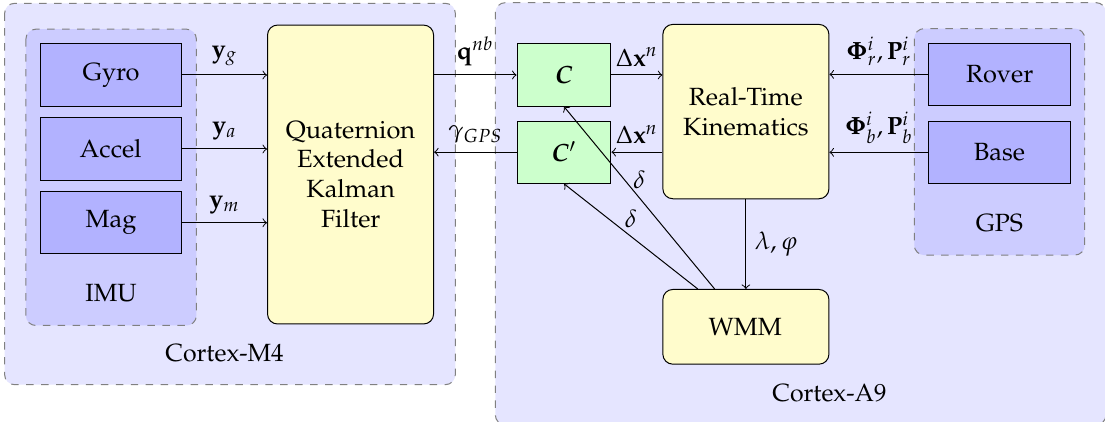
Figure 2. Proposed attitude determination